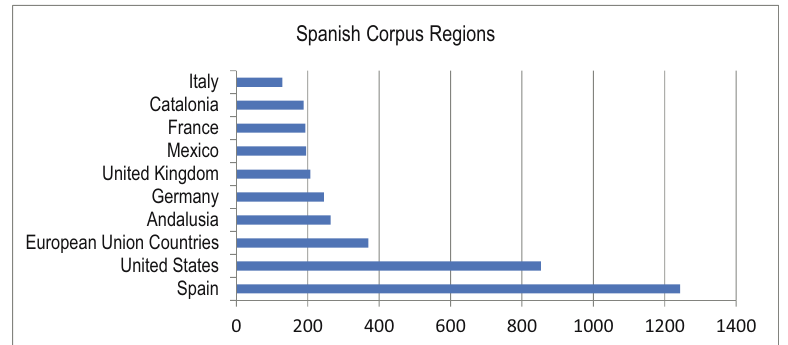
Figure 6: Most mentioned geographical areas in the Spanish